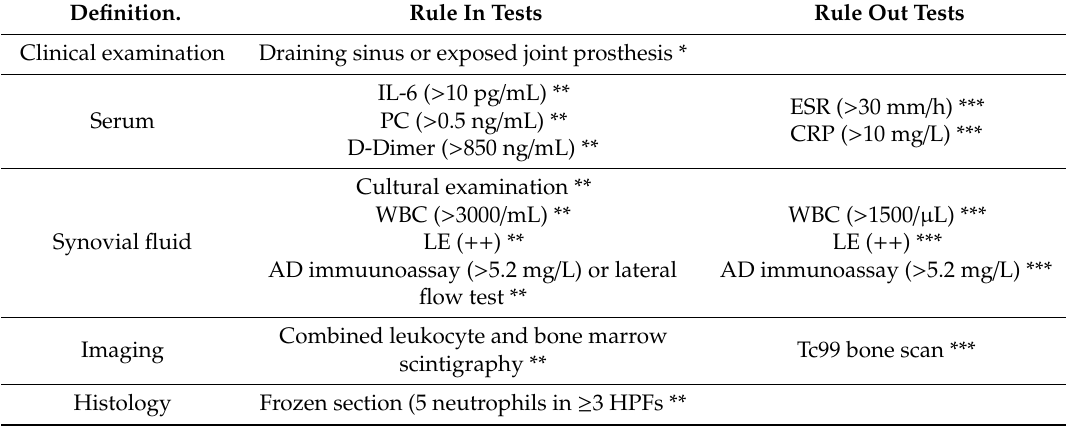
Table 10. Rule In and Rule Out tests of the modified WAIOT